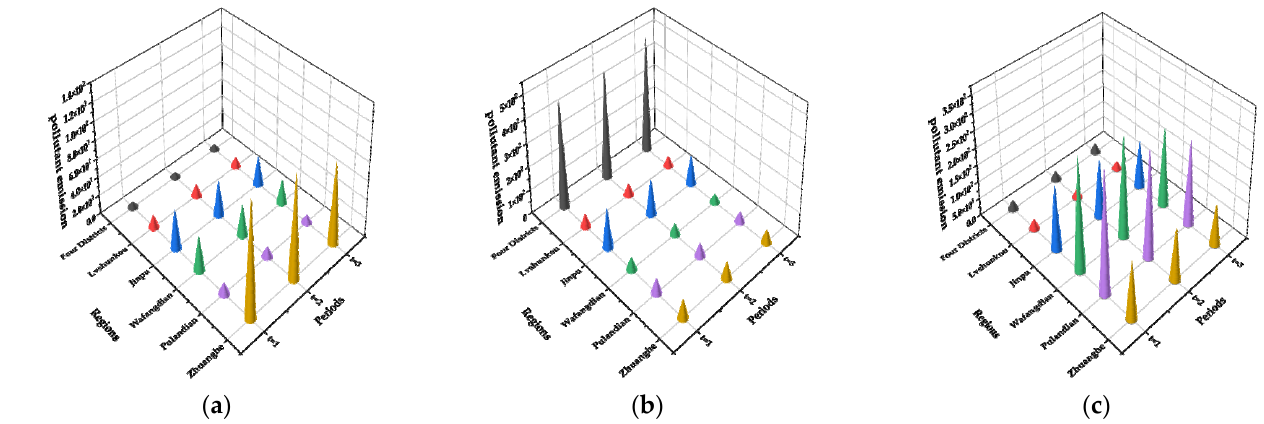
Figure 12. T p emissions of various sectors: ( a ) industry; ( b ) municipal; ( c ) agriculture (tons/year).